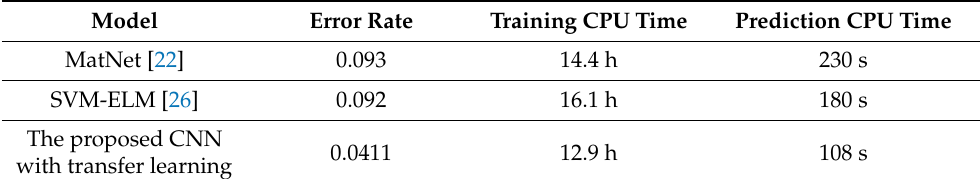
Table 10. Comparison results.